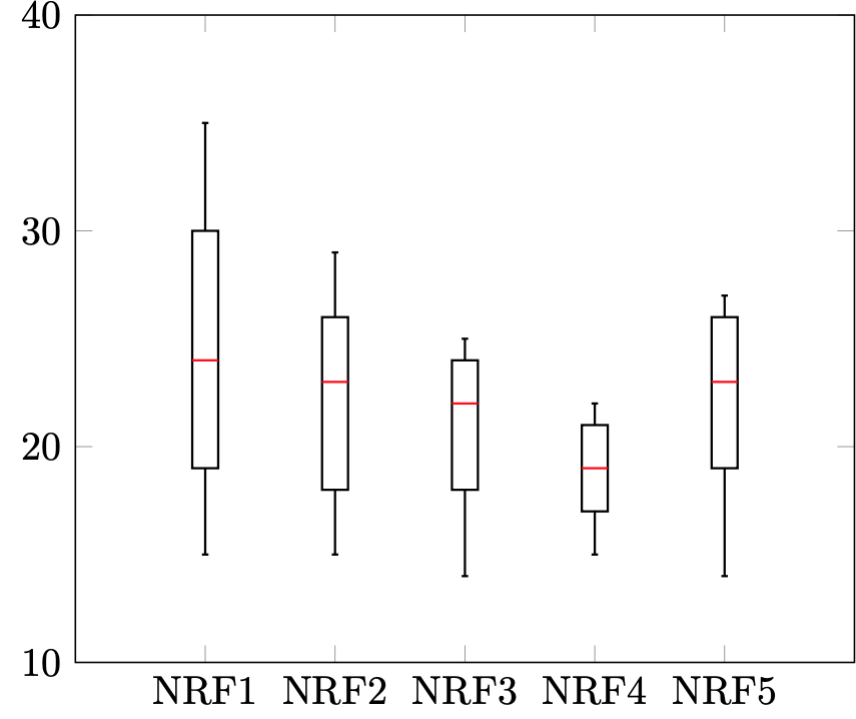
Figure 10. NRF Instances.